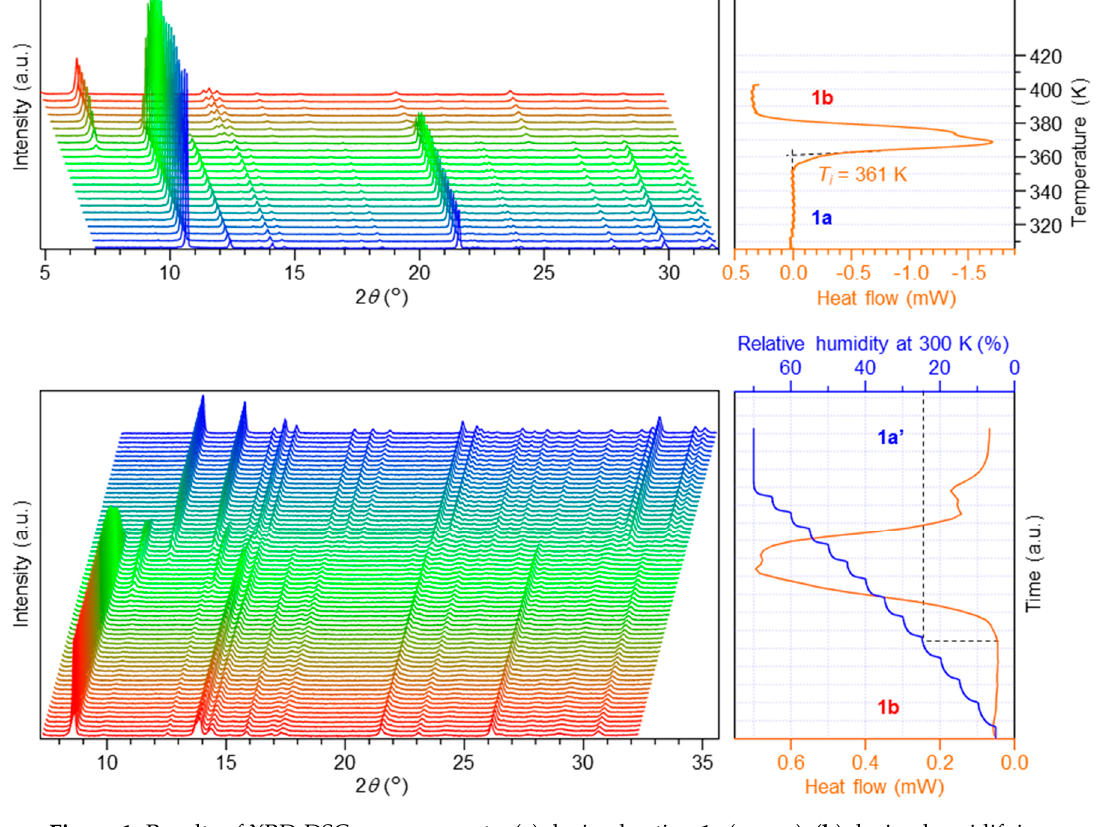
Figure 1. Results of XRD-DSC measurements: ( a ) during heating 1a (upper), ( b ) during humidifying 1b (lower).